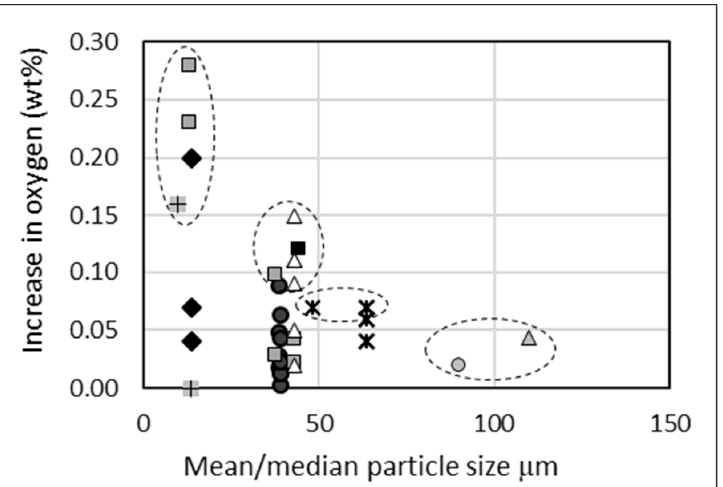
Figure 6. Increase in oxygen content from powder to sintered compact versus mean/median particle size. Sponge fines and HDH powder only, direct powder rolling (DPR), cold isostatic pressing (CIP), and die pressing. 10 sources identified by different markers. Largest increases in oxygen per study are circled to show the maximum increases per mean/median particle size, and regardless of processing/powders used, the increasing risk of oxygen contamination as powder size decreases.